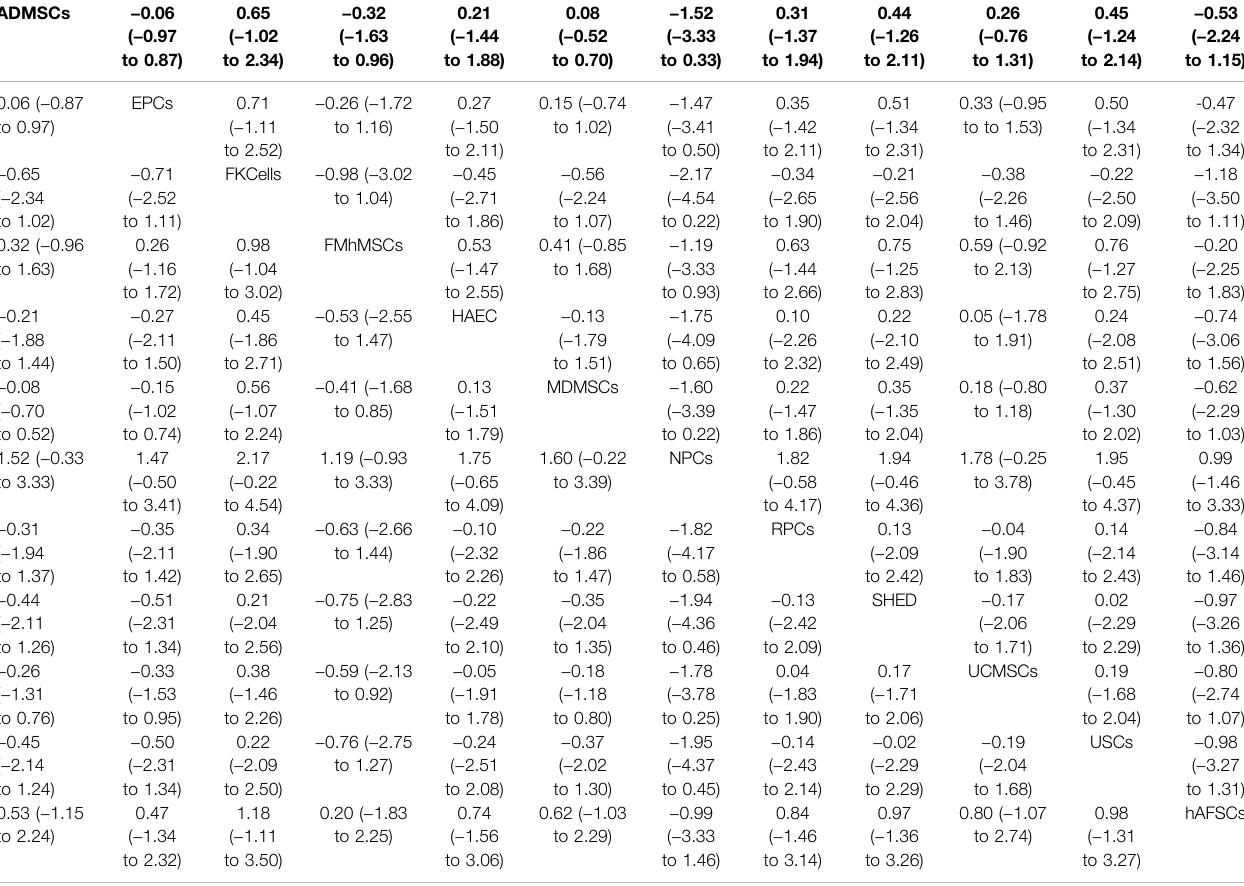
TABLE 2 | Network Meta-analysis results of serum creatinine levels in stem cell groups at 1 day after administration. ADMSCs − 0.06